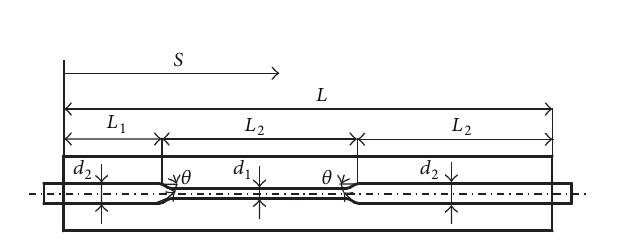
Figure 2: Schematic of the experimental tube.